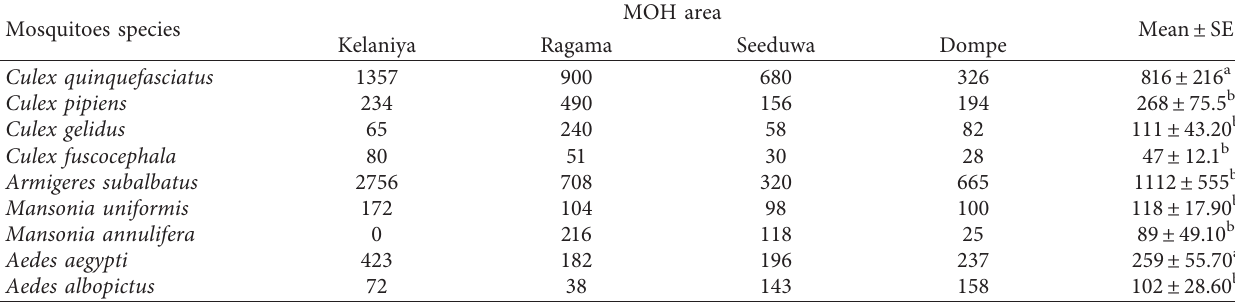
Table 2: Adult mosquito abundance in four MOH areas.